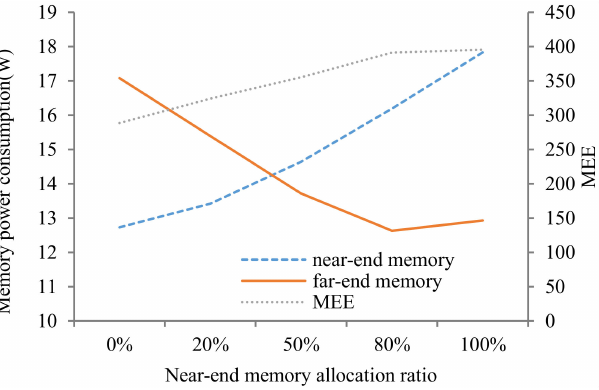
Figure 15. Experiment of singe thread STREAM array size of 16 G under NUMA architecture.